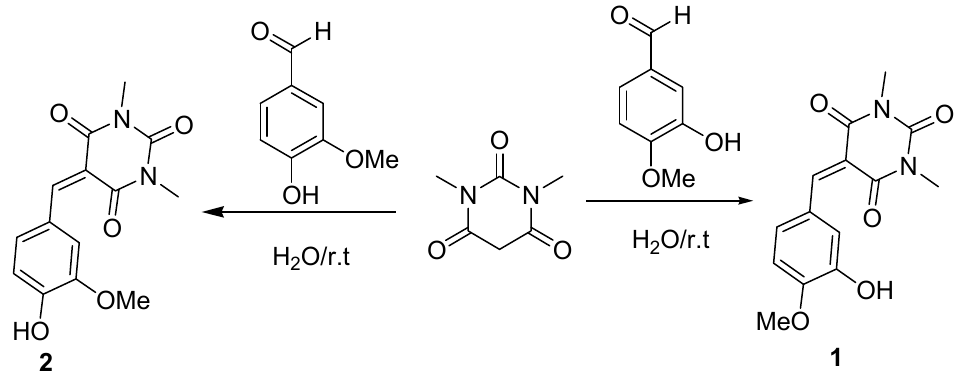
Scheme 1. Synthesis of arylidene-1,3-dimethylpyrimidine-2,4,6(1 H ,3 H ,5 H )-trione derivatives 1 and 2 .